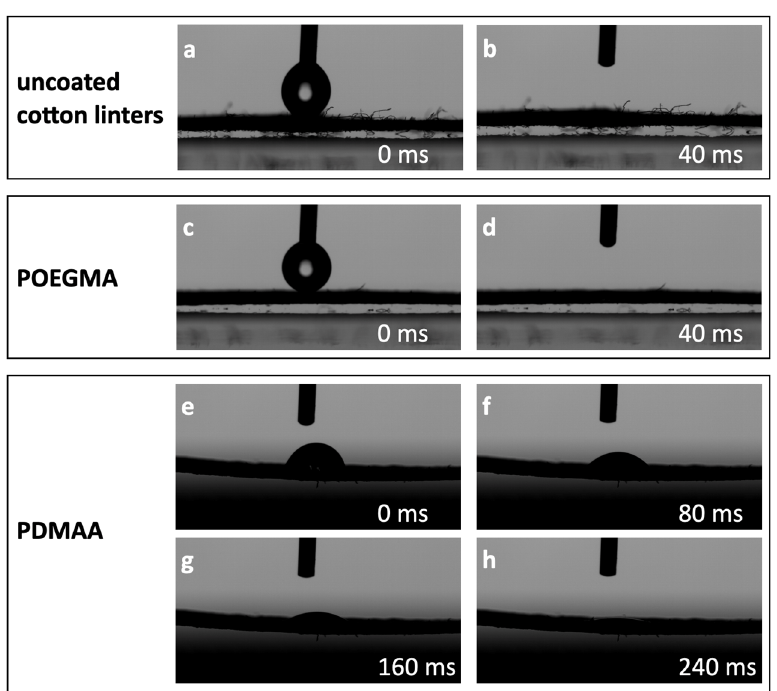
Figure 3. Dynamic water contact angle changes on uncoated ( a , b ), POEGMA-coated ( c , d ), and PDMAA-coated ( e – h ) cotton linter paper. A 2 µL drop of water is applied to the paper, and the time until full imbibition is measured. The total imbibition time for the PDMAA experiment was 7 frames (280 ms), and, for the POEGMA-coated and uncoated paper, less than 1 frame (40 ms).